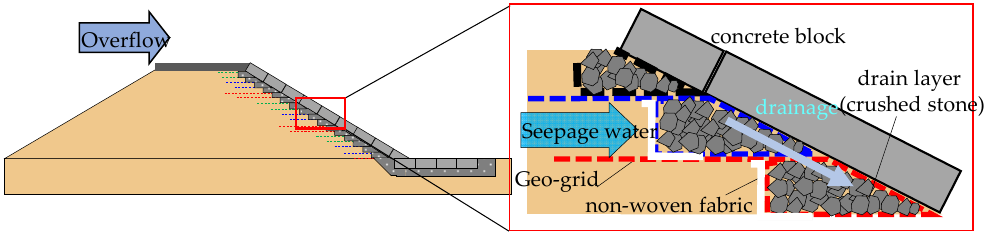
Figure 2. Schematic view of basic composition of the laminar drain reinforcement (LDR) levee.